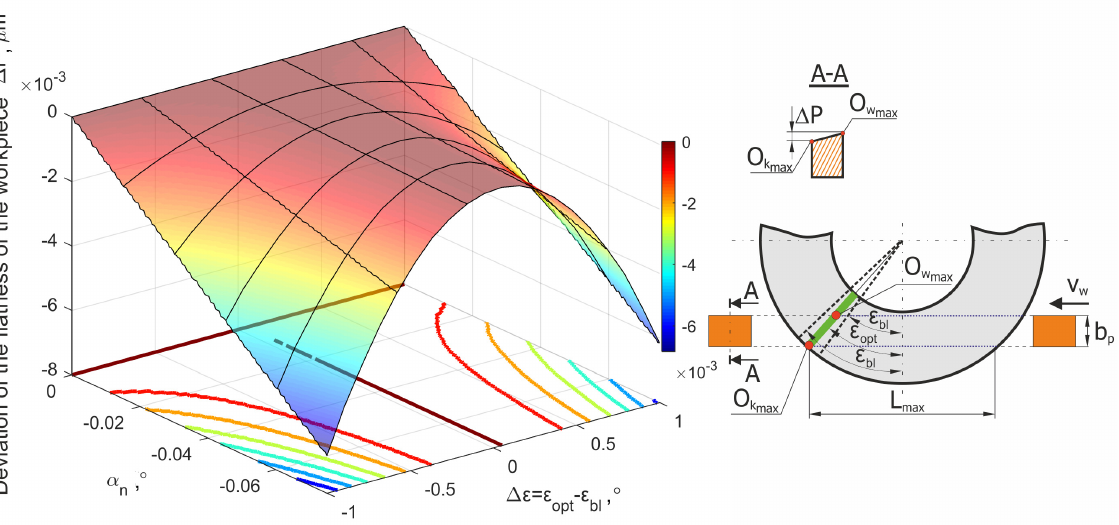
Figure 7. Values of the flatness error ∆ P as a result of deviations in the tilt angles of the grinding wheel.